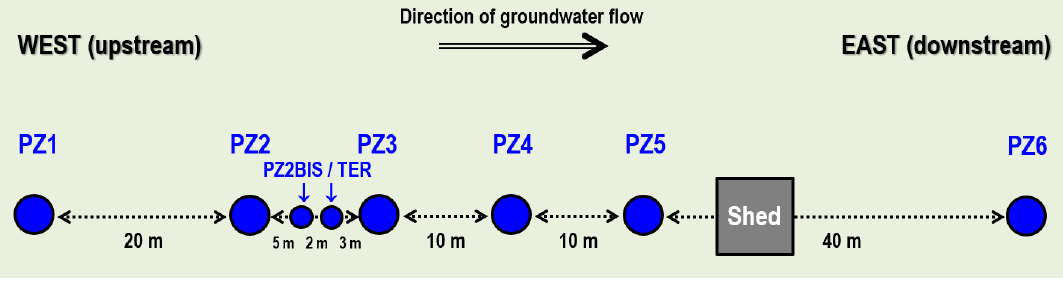
Figure 2. Detailed plan view of the experimental site.